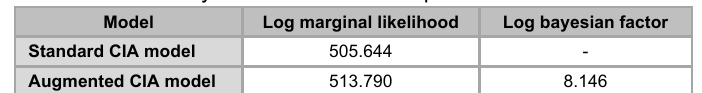
Bayesian estimation